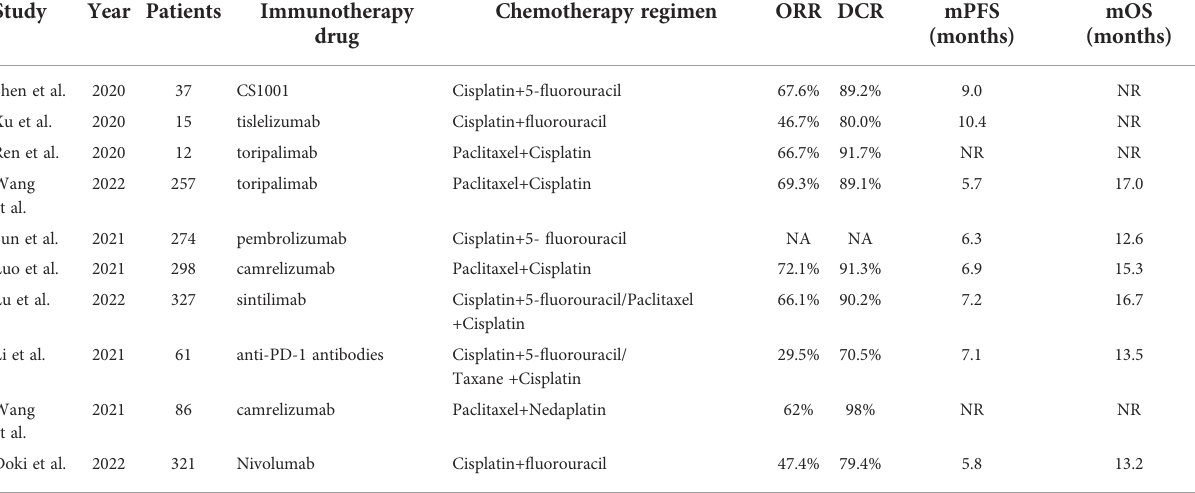
TABLE 1 Characteristics of included studies.